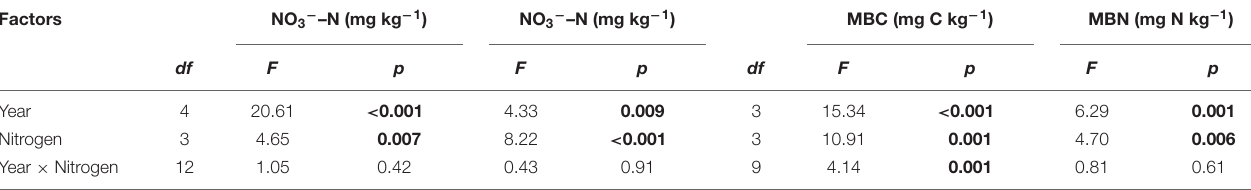
TABLE 1 | Results of repeated measures analysis of variance (RMANOVA) on the individual and interactive effects of N addition (N), year on soil properties. Factors